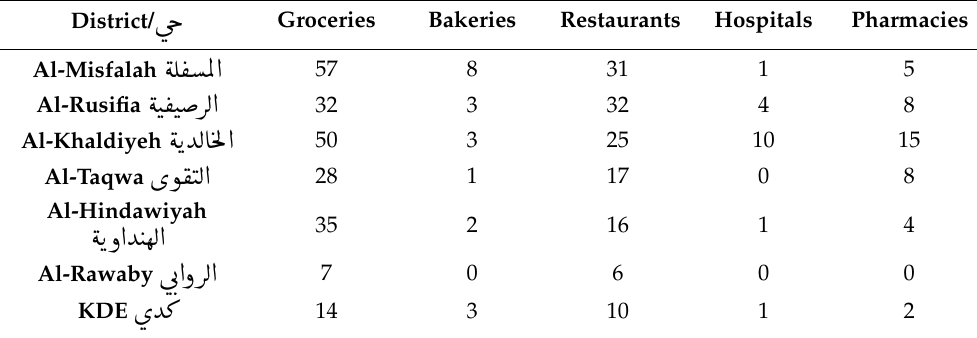
Figure 5. Khalidiyah district center. Source: https://maps.holymakkah.gov.sa/ (accessed on 6 October 2022). Table 1. Waste resource in the al-Misfalah district part of Mecca.